Question: What direction does the quantity move in — increasing or decreasing?
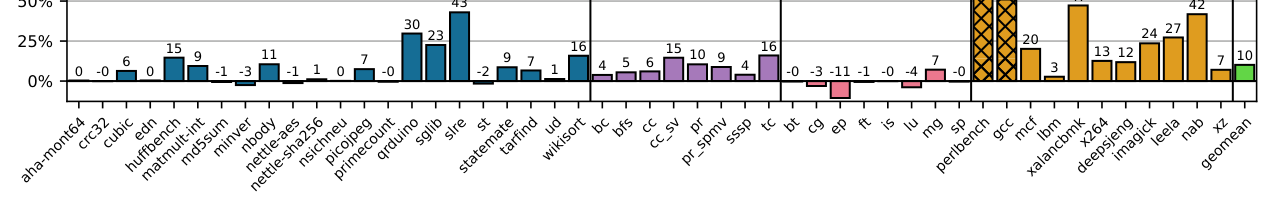
Answer: increasing